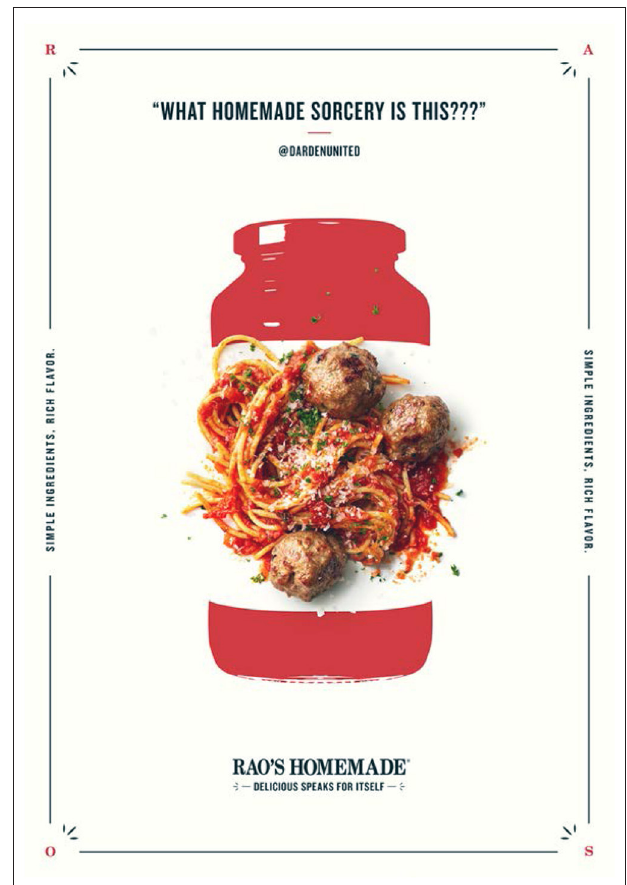
FIGURE 2 | Example 1: Rao’s Homemade, BSSP, Sausalito, CA (USA), Lürzer’s Archive 2/19: 36.